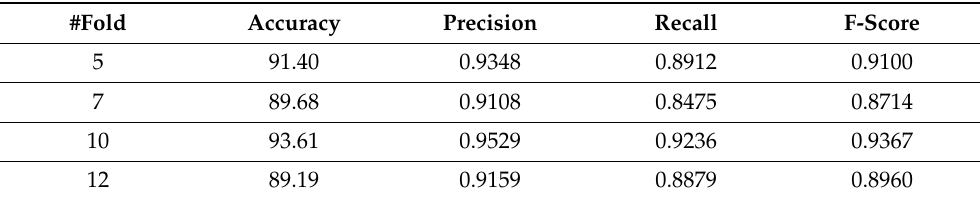
Table 2. The performance of the CNN architecture in different folds of cross-validation with a batch size equal to 100 and for 100 epochs.